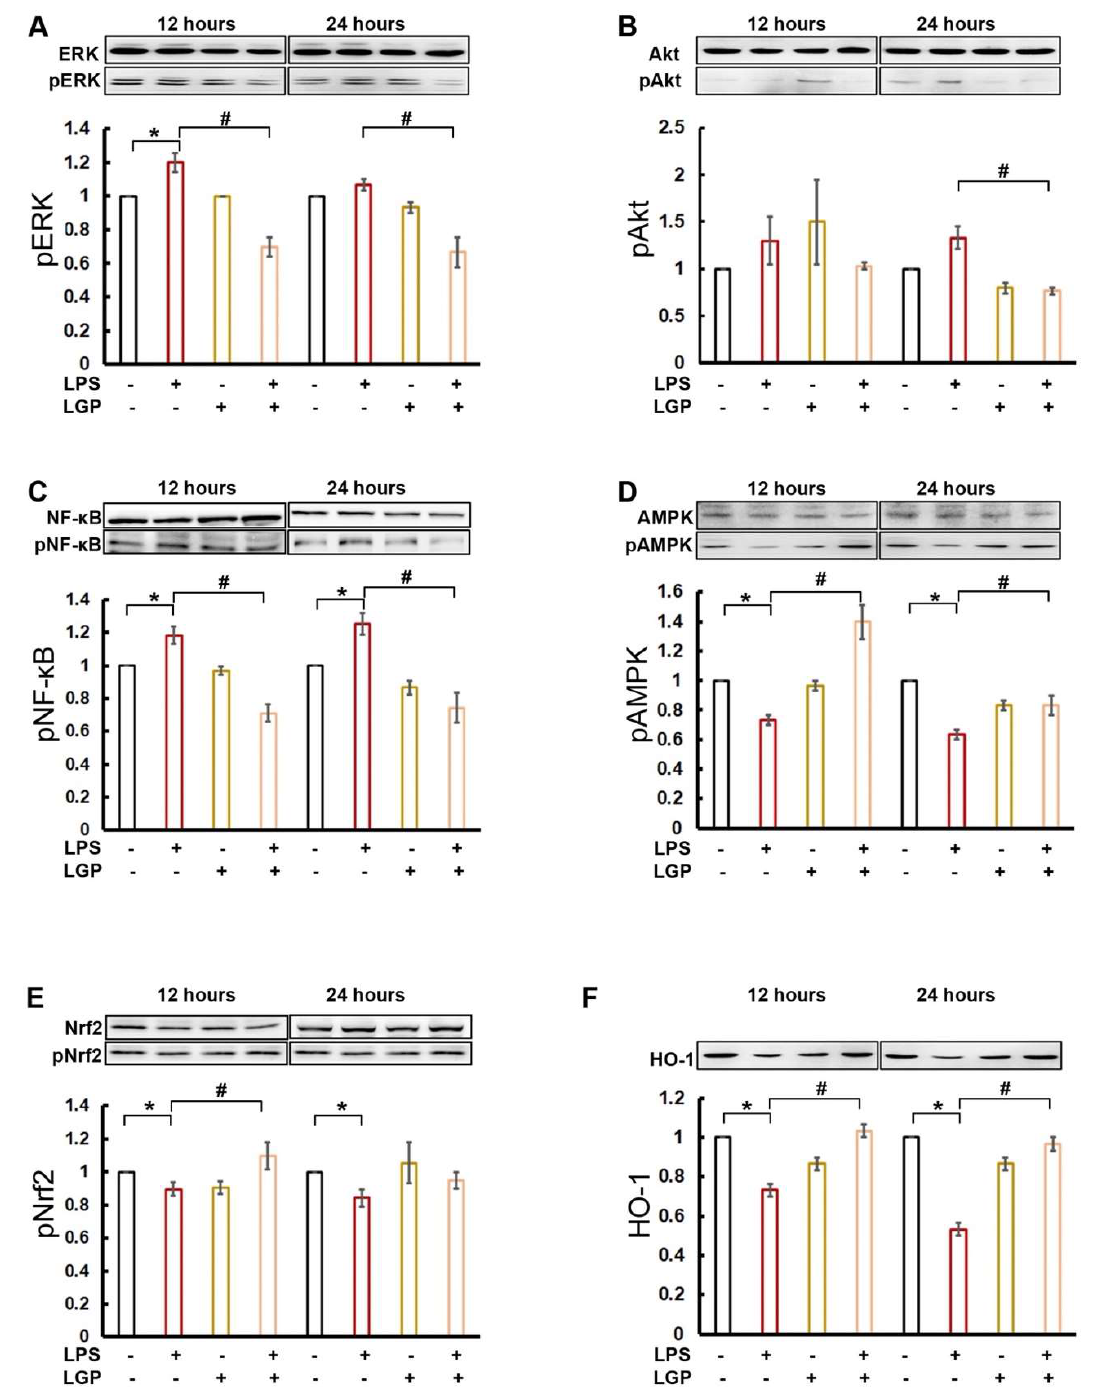
Figure 3. Western blotting of NRK-52E cells 12 or 24 h after incubation with/without 10 μg/mL LPS or 0.1 μg/mL linagliptin (LGP). Representative image and quantification results for inflammatory mediators include ( A ) extracellular-signal-regulated kinases (ERK) and phospho-ERK (p-ERK at tyrosine 204), ( B ) Protein kinase B (Akt) and phospho-Akt (serine 473), ( C ) NF-κB p65 and phospho-NF-κB p65 (at serine 536), ( D ) AMP-activated protein kinase (AMPK) ⍺ 1/2 and phospho-AMPK ⍺ 1/2 (at threonine 183 and threonine 172, respectively), ( E ) Nrf2, phosphor-Nrf2 (at serine 42), and ( F ) HO-1. The band of each sample was quantified by software ImageJ 1.47t, and all results were normalized to the value of the control β-actin. * p < 0.05 for the LPS group compared with the Vehicle group. # p < 0.05 for the LPS + Linagliptin group compared with the LPS group.